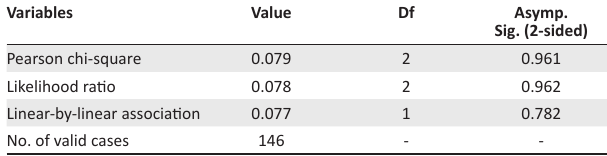
TABLE 3b: Finance constraint: chi-square tests.